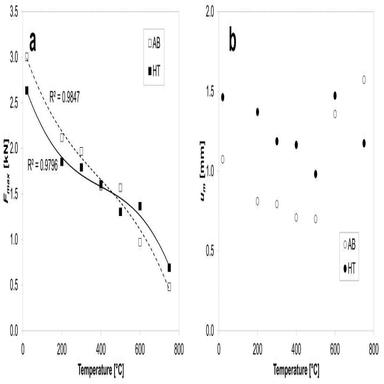
Key characteristics obtained from SP testing for LPBF DSS 2205 in the as-built and heat-treated condition over the tested temperature range (a) Fmax (b) um.